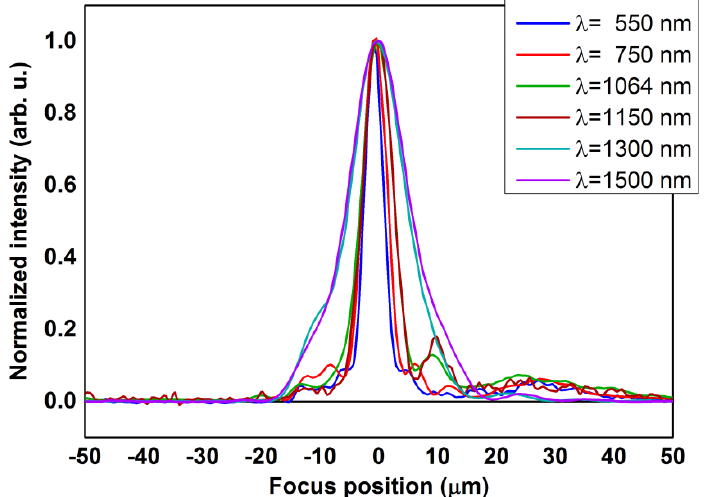
Figure 5. Reflectance intensity profiles at different wavelengths as a function of focus axial